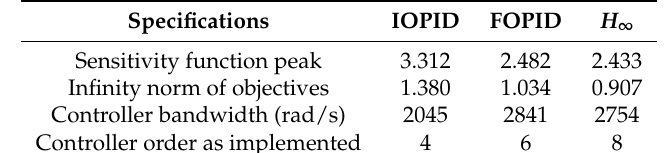
Figure 29. Bode plots of the thrust AMB sensitivity and complementary sensitivity functions under the FOPID controller tuned by the DE algorithm. Table 9. Comparison of performances in the thrust AMB system.